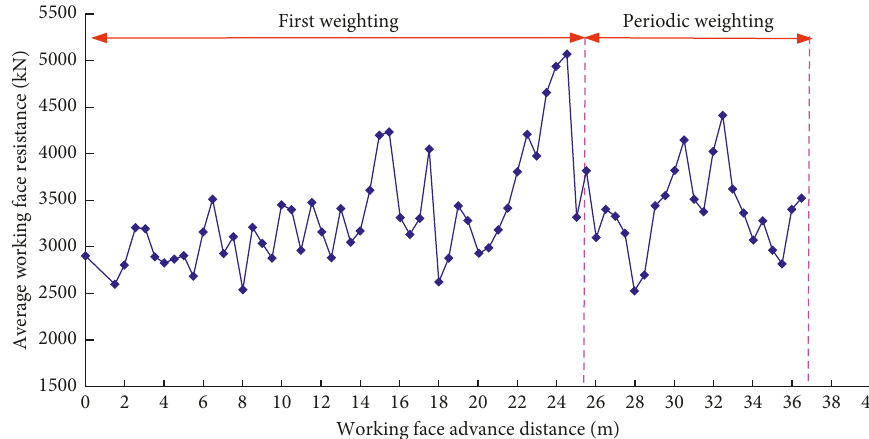
Figure 9: Measured average working resistance in the working face